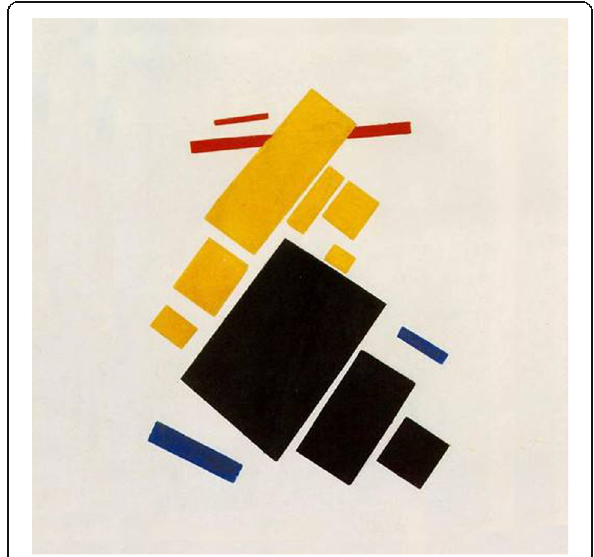
Fig. 17 Malevich ’ s abstract painting example